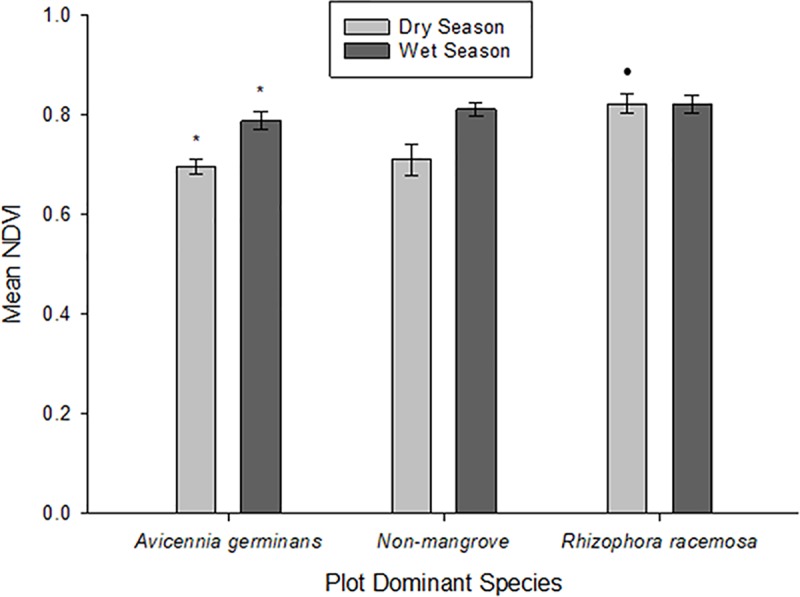
Mean NDVI values for three dominant (90% of overstory biomass) tree species in the Cabuyal estuary.Measurements derived from 10cm/pixel resolution UAS imagery taken September through November 2017 for wet season (n = 13) and January through February 2018 for dry season (n = 23) measurements. * represents significant difference of means for between season measurements of plot NDVI from paired t-tests. • represents significant difference of means for within season measurements of plot NDVI from one-way ANOVA and Tukey-HSD post-hoc tests. Error bars represent standard error from the mean.